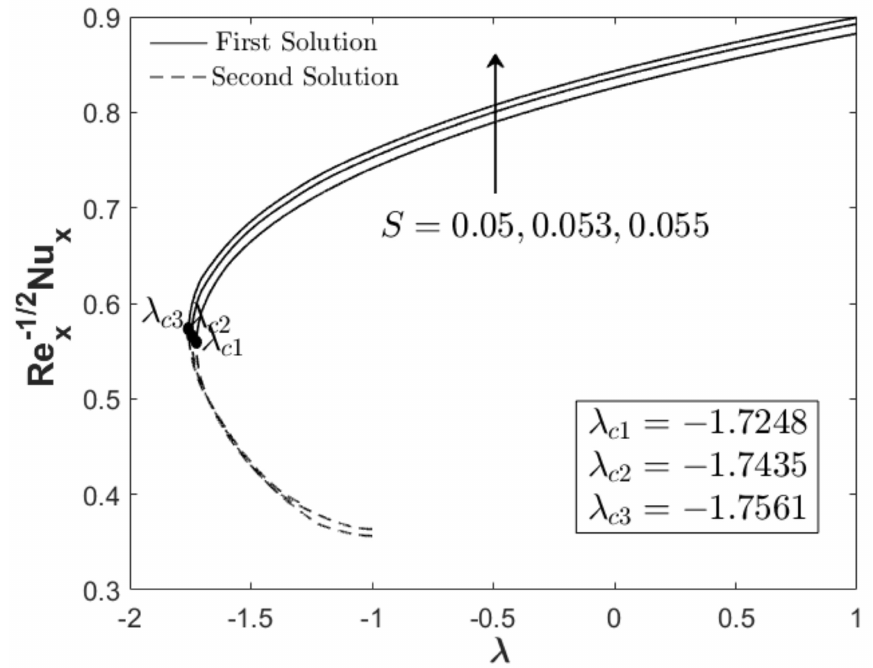
Figure 5. Re − 1/2 x Nu x towards λ when m = 0.3, φ hnf = 0.02, and variety S